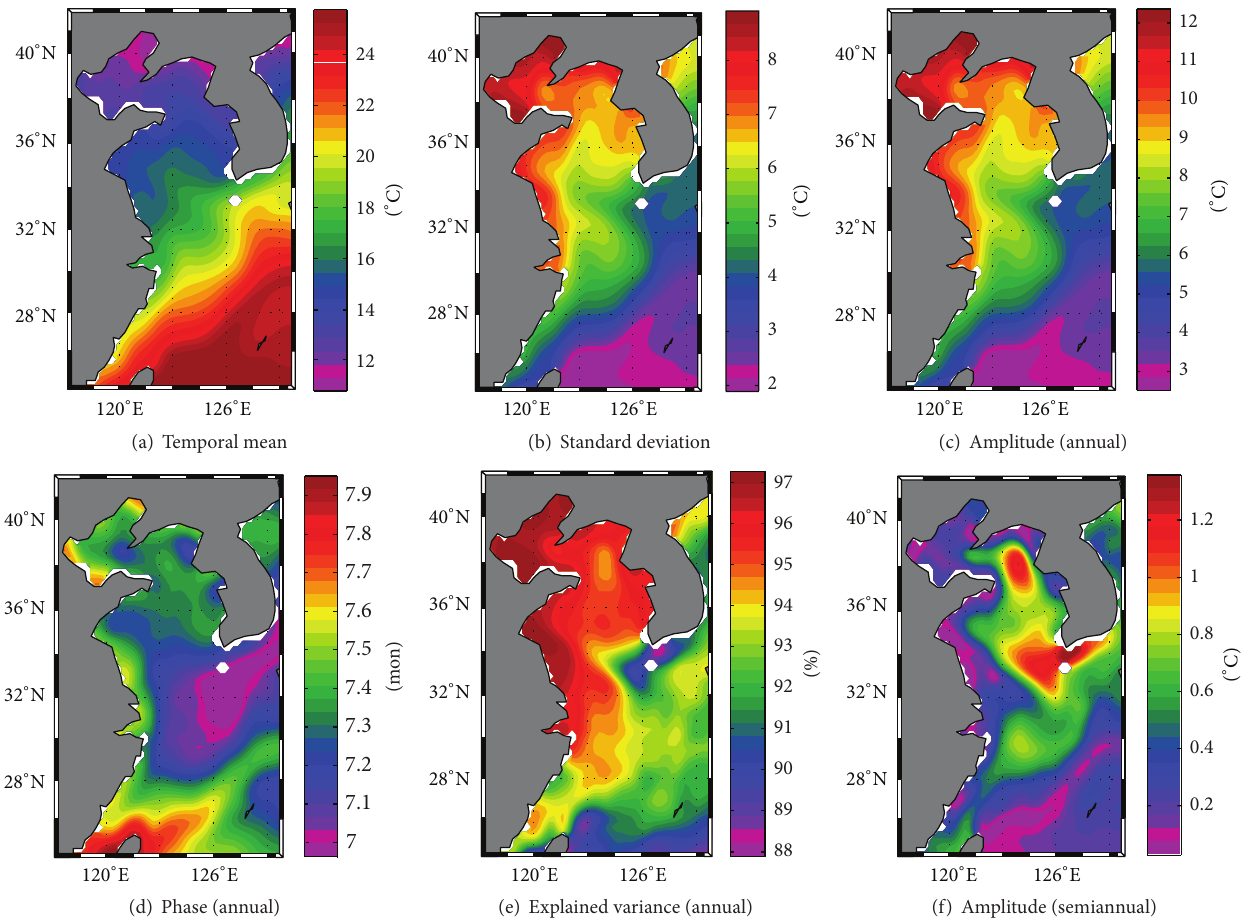
Figure 3: Spatial distribution of the temporal mean SST (a) and its corresponding standard deviation (b). Spatial distribution of the amplitude (c) and the phase (month) (d) and the percentage of explained variance for the annual harmonic (e). Spatial distribution of the amplitude (d) for the semiannual